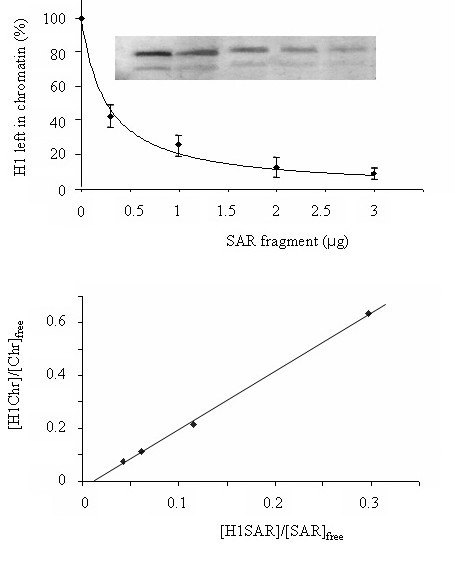
Displacement of histone H1 from chromatin by SAR DNA. (A) A chromatin sample containing 20 μg of DNA was titrated with a SAR fragment (657 bp). Displaced H1 formed an insoluble complex with the SAR that was separated by centrifugation. The inset shows the H1 remaining on the chromatin. The experimental points were fitted to a hyperbolic function. (B) A plot of [H1Chr]/[Chr]free on the ordinate and [H1SAR]/[SAR]free on the abscissa gives a straight line. The slope of the line corresponds to kChr/kSAR. The points are the average of three experiments. The bars show the interval spanned by the extreme values.